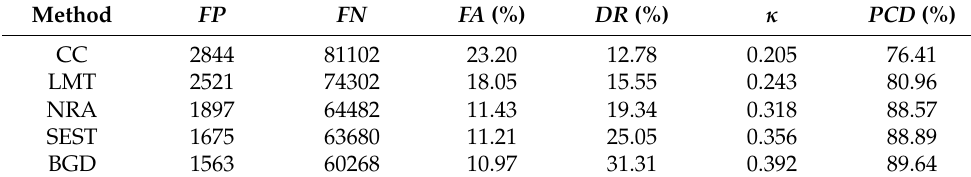
Table 6. Comparison of results from all the six methods using dataset 3 after median filtering.